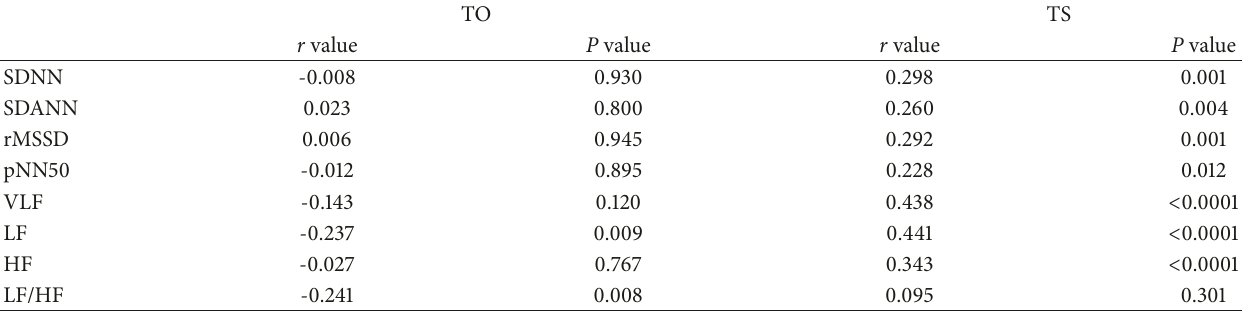
Table 5: Spearman correlation analysis of HRV and HRT in HP